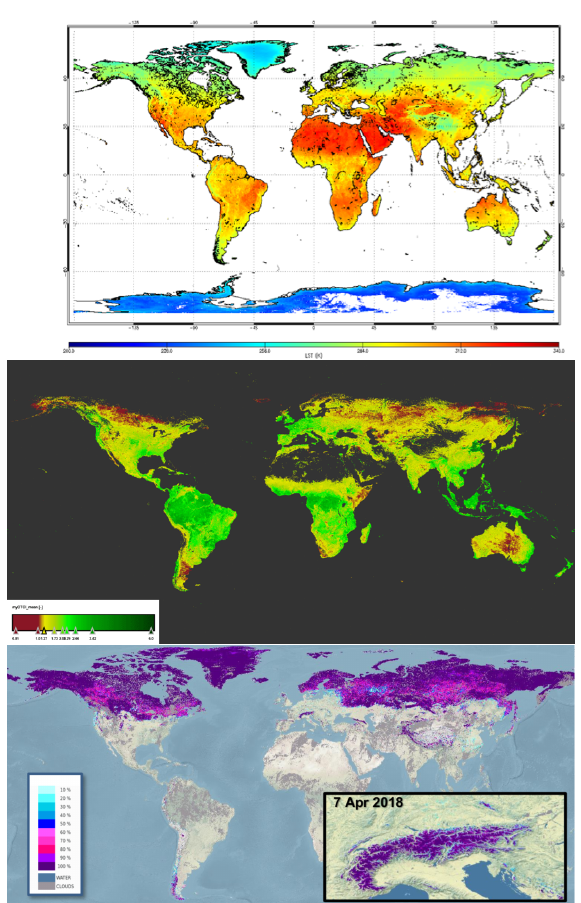
Figure 2. Sentinel-3 derived kilometre-scale products for Earth System Modelling. ( top ) SLSTR Land Surface Temperature monthly composite for September 2016 (Credit: D. Ghent, University of Leicester) ( middle ) OLCI Terrestrial Chlorophyll Index April–May 2017 (Credit: University of Southampton–J. Dash/Brockman Consult (S3-MPC)) ( bottom panel ) SLSTR Snow Extent Product, 5–10 April 2018 (Credit: ENVEO). Copyright: All figures contain modified Copernicus Sentinel data (2018), processed by ESA, CC BY-SA 3.0